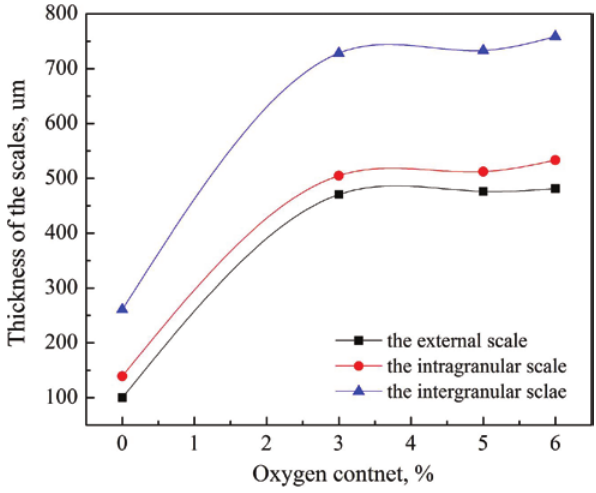
Fig. 4: Relationships between the thickness of the scales and oxygen content